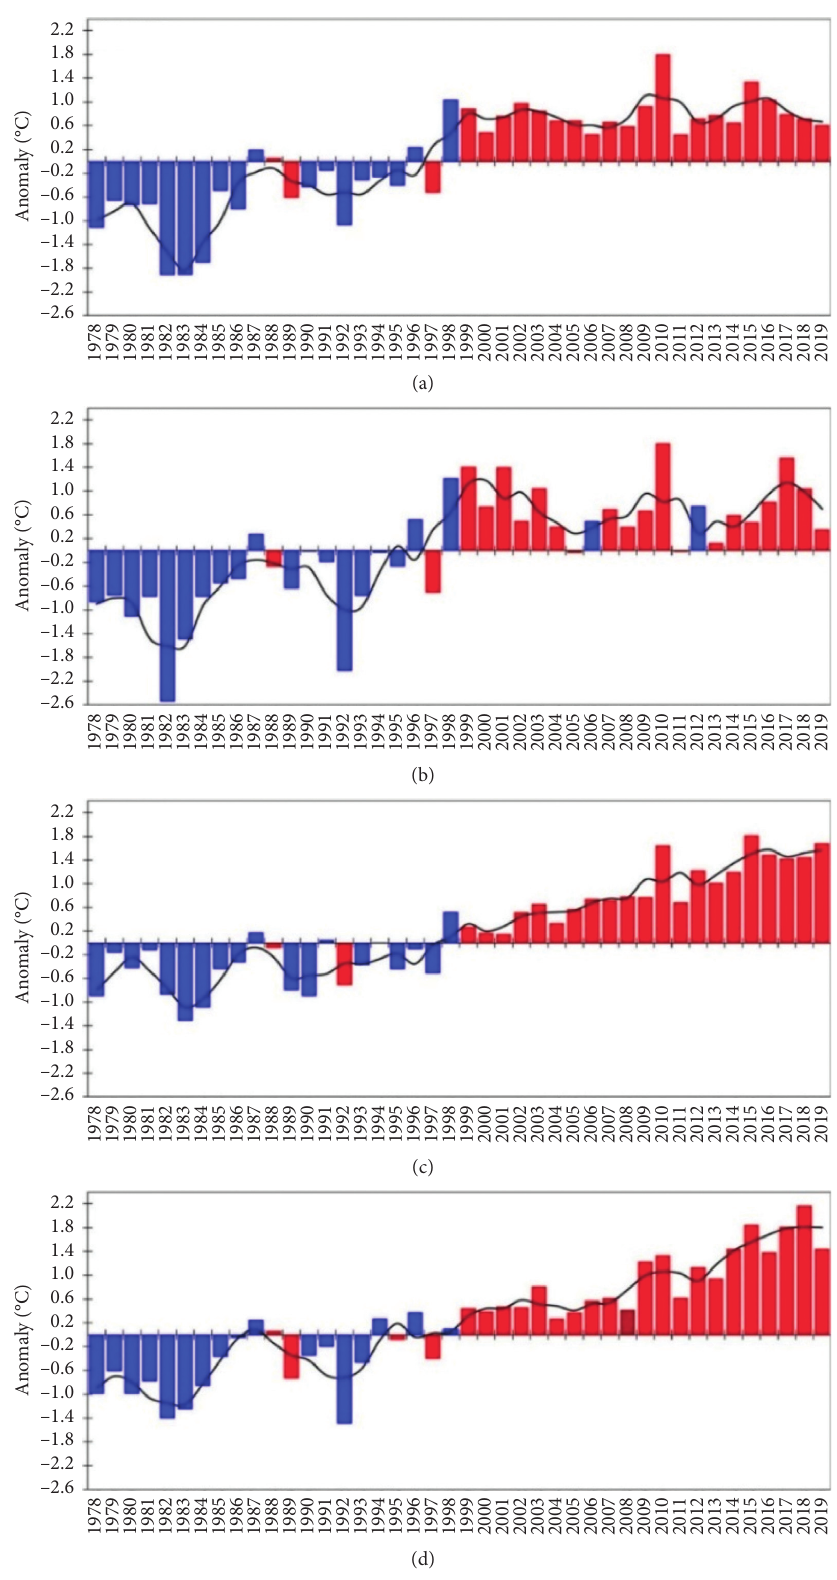
Figure 5: Anomalies of the country-averaged annual (a) maximum of Tmax (TXx), (b) minimum of Tmax (TXn), (c) maximum of Tmin (TNx), and (d) minimum Tmin (TNn) in Saudi Arabia for the period 1978–2019. The anomalies are relative to 1978–2019 mean values in Table 1. The curves are 5-year running